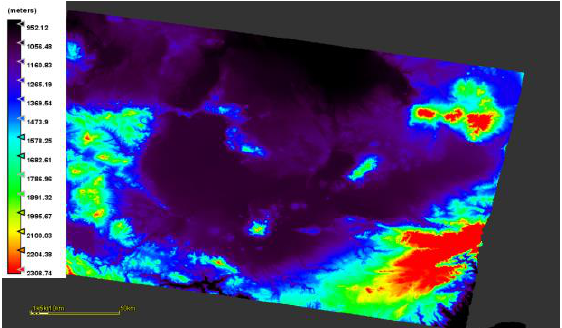
Figure 6. DEM Generated With Bilinear Interpolation